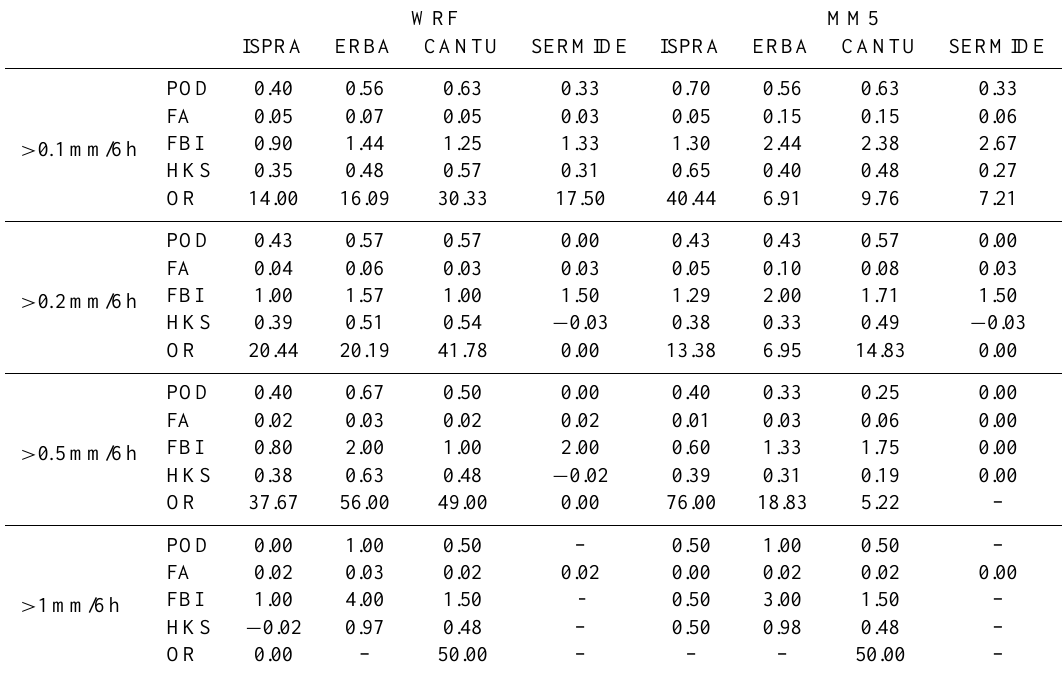
Table 3f. Hit rate statistics for the rain data, June 2005. WRF MM5 ISPRA ERBA CANTU SERMIDE ISPRA ERBA CANTU SERMIDE